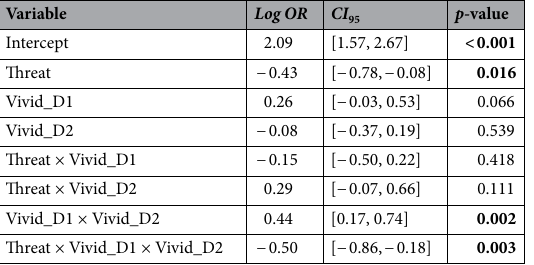
Table 1. Multilevel regression output corresponding to the moderating role of premise memory vividness.